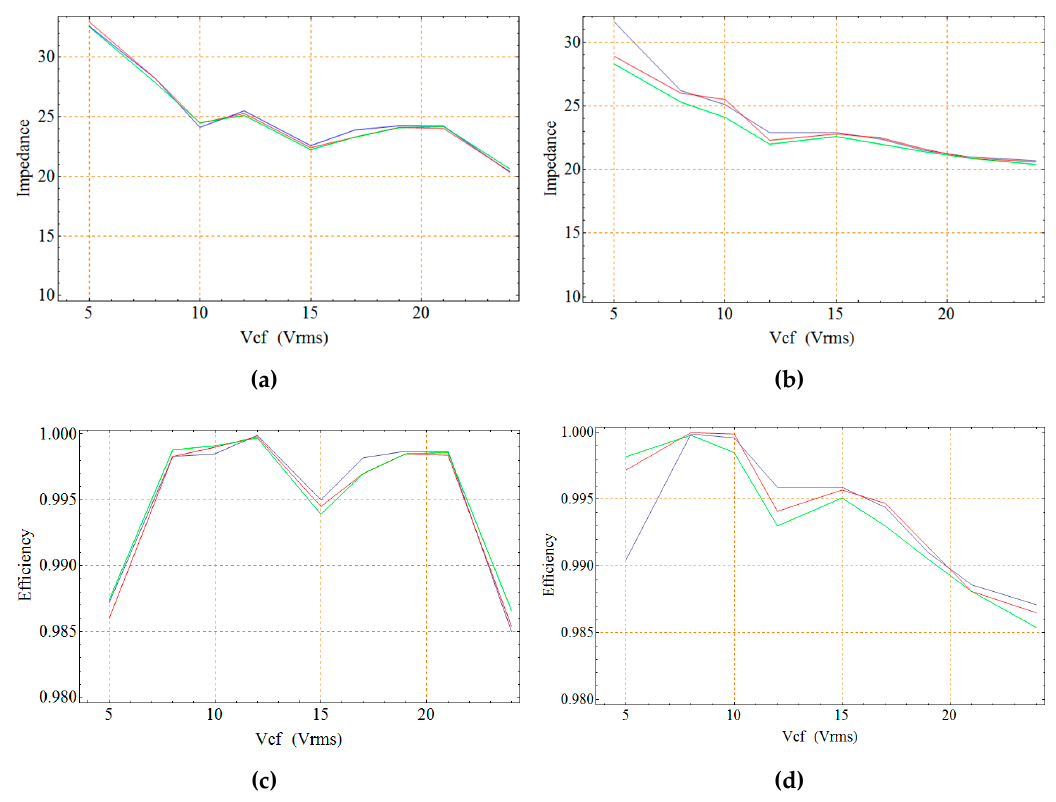
Figure 22. Experimental tests with sinusoidal signals, C f = 10 µ F: ( a ) HBB input impedance, ( b ) Sepic input impedance, ( c ) HBB matching e ffi ciency, and ( d ) Sepic matching e ffi ciency.